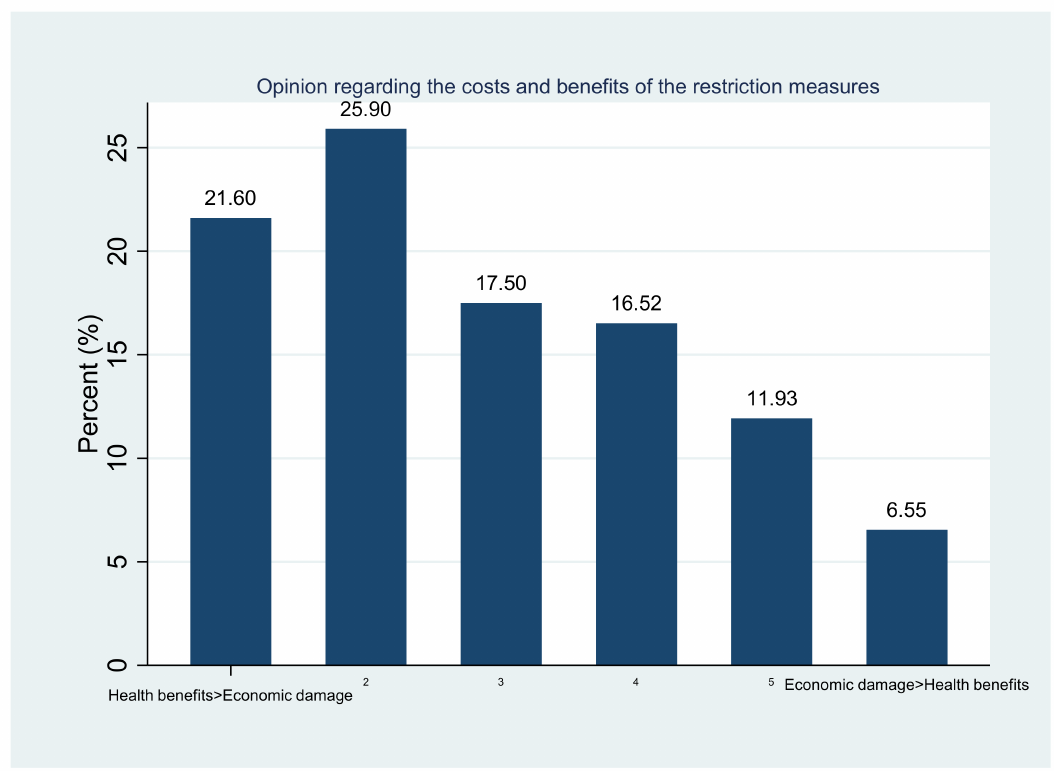
Figure 2. Opinion regarding the costs and benefits of the restriction measures.